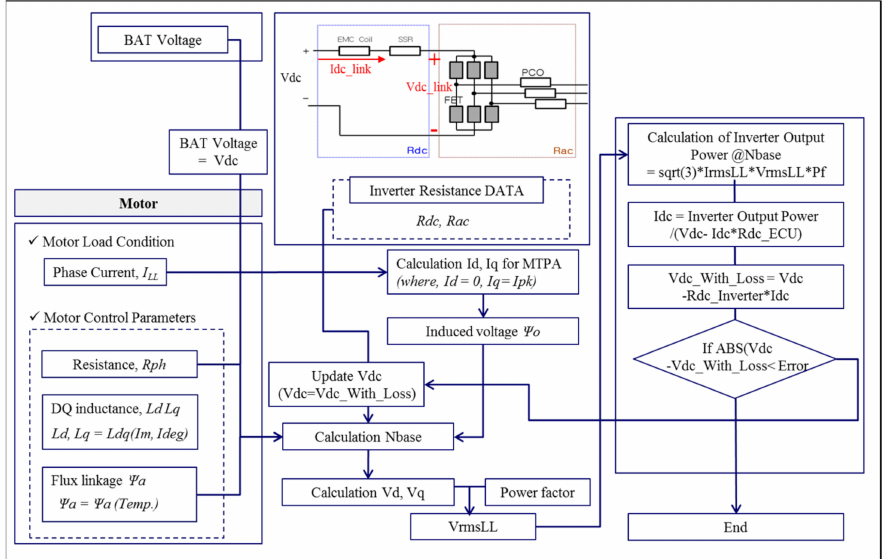
Figure 4. Calculation of the motor input voltage as an inverter output